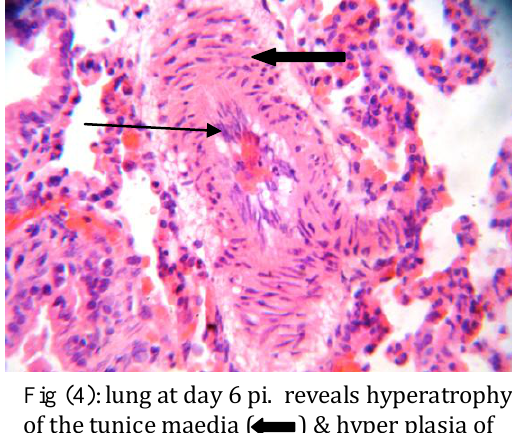
Fig (4): lung at day 6 pi. reveals hyperatrophy of the tunice maedia ( ) & hyper plasia of the tunica antina ( ) ( H&EX40).